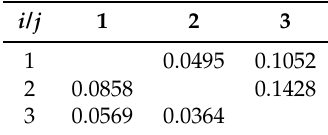
Table 2. Values δ L obtained by cross-testing of LT model. Mean value δ L = 0.0530.